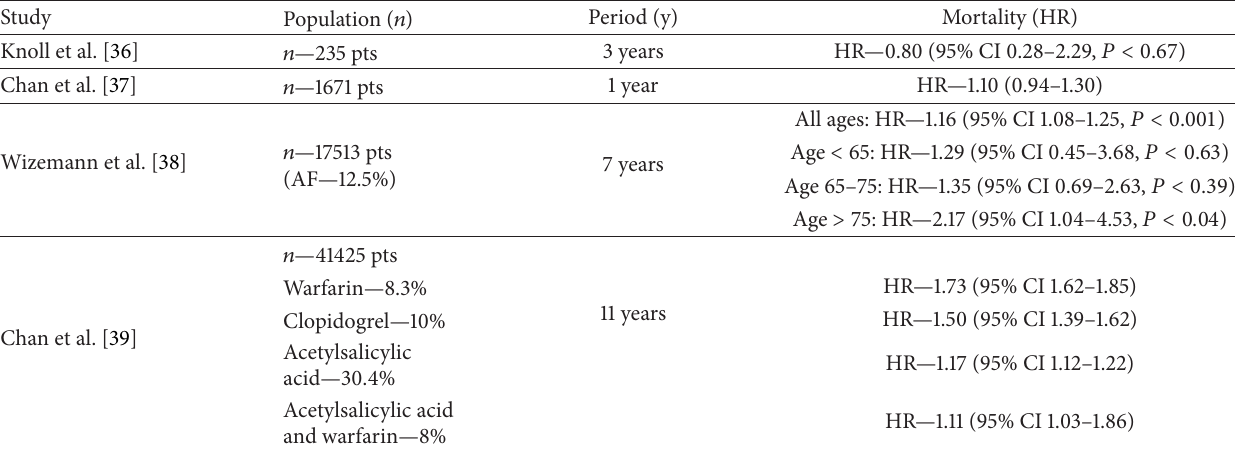
Table 3: Mortality risk in haemodialysis patients with atrial fibrillation treated with